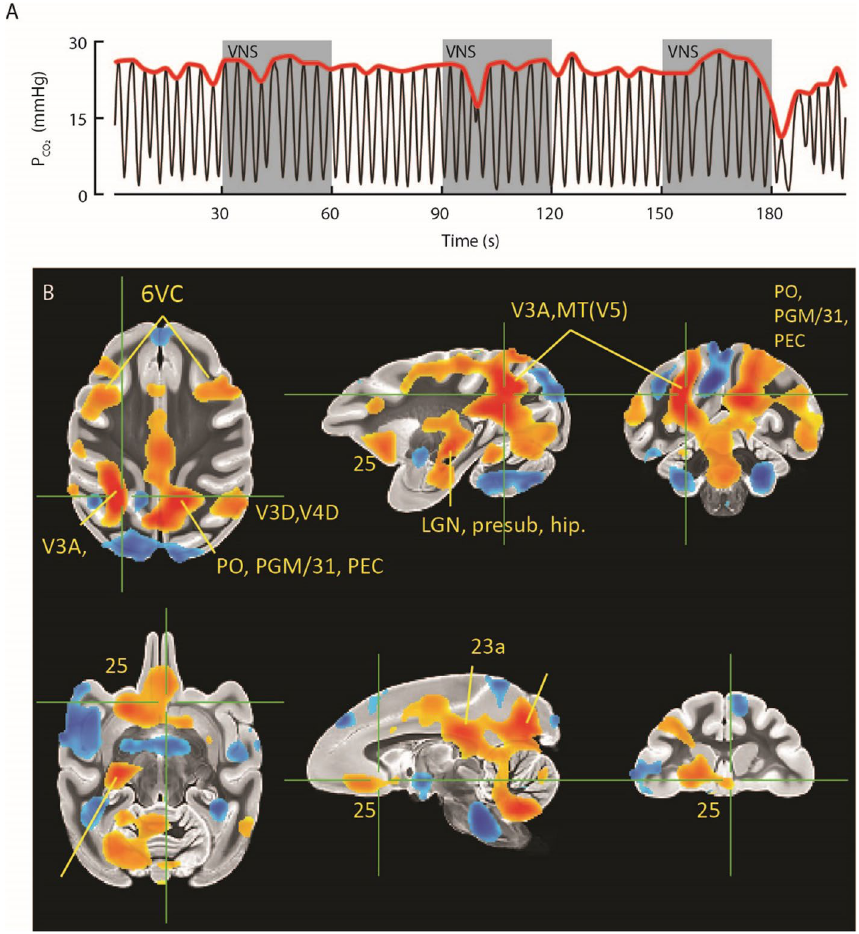
Fig. 5 Neural correlates of VNS via functional MRI. A VNS applied to an awake NHP ( n of respiration consistent with the start of stimulation (gray bands). B BOLD fMRI measured during VNS revealed statistically significant areas of activation and deactivation in both cortical and subcortical structures. See results for a full description of activated